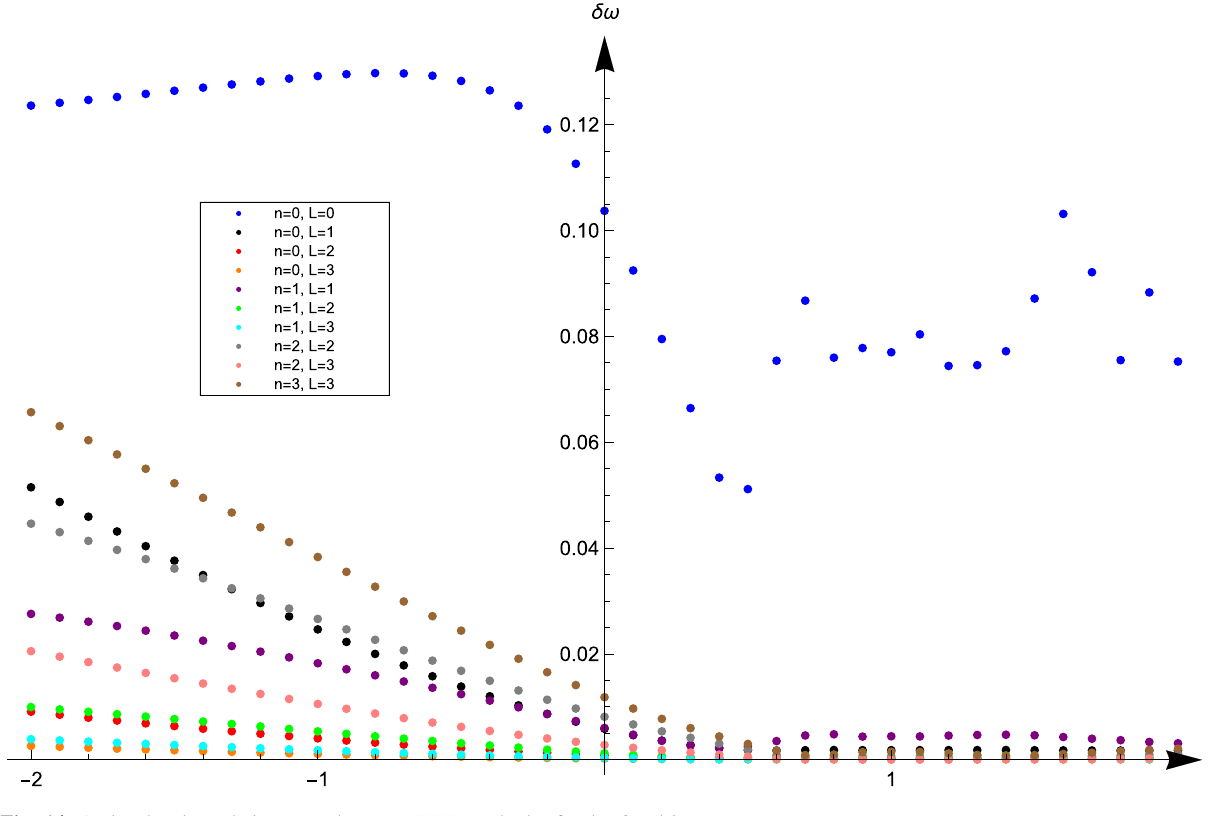
Fig. 14 A plot showing relative errors between WKB methods of order 6 and 3